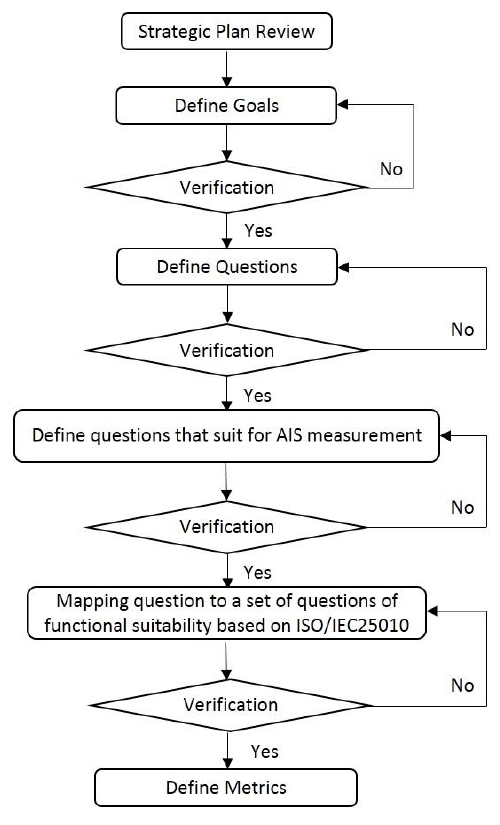
Fig.2. Defining GQM